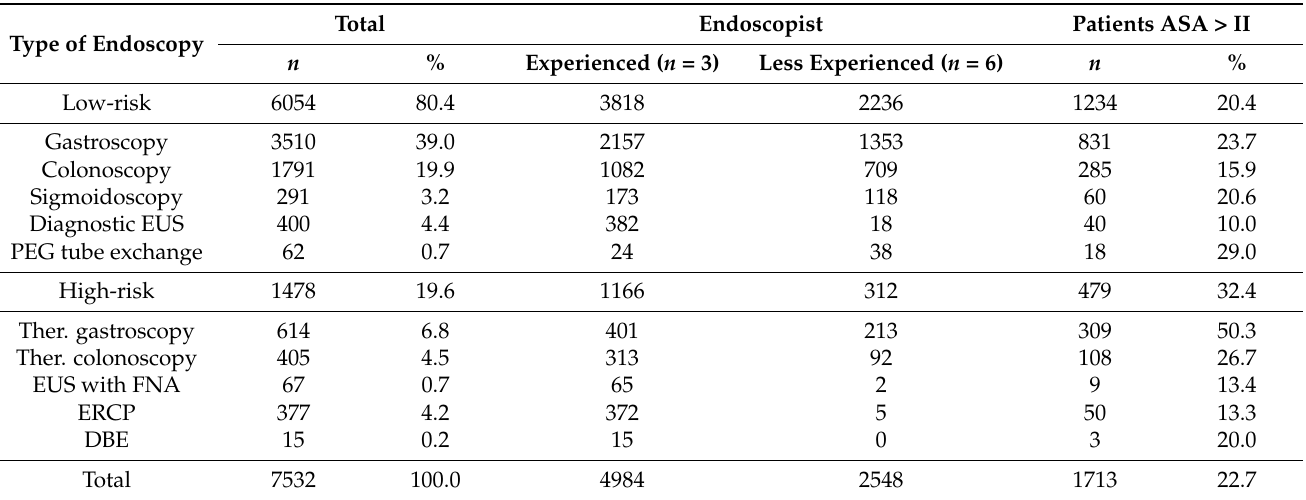
Table 2. Endoscopic procedures, endoscopists, and patient risk categories.